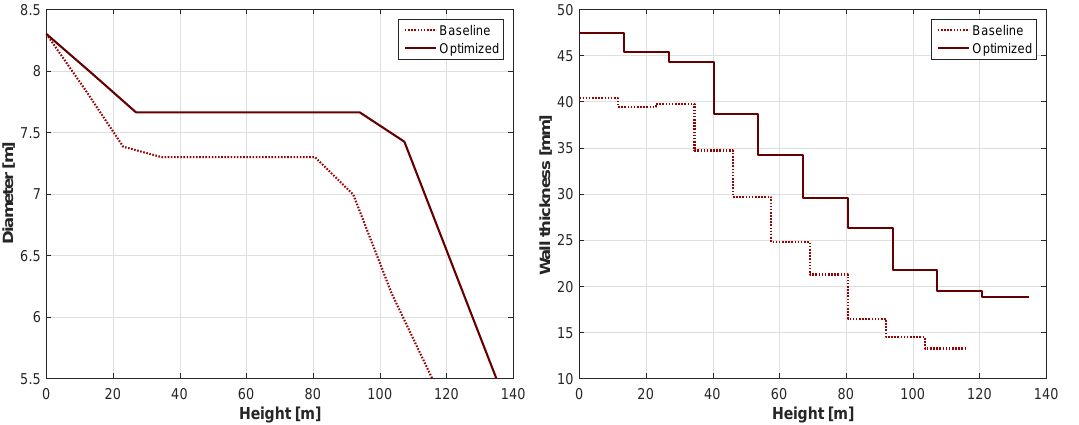
Figure 10. Tower outer diameter and wall thickness distributions of the baseline and the optimized 10MW wind turbines.